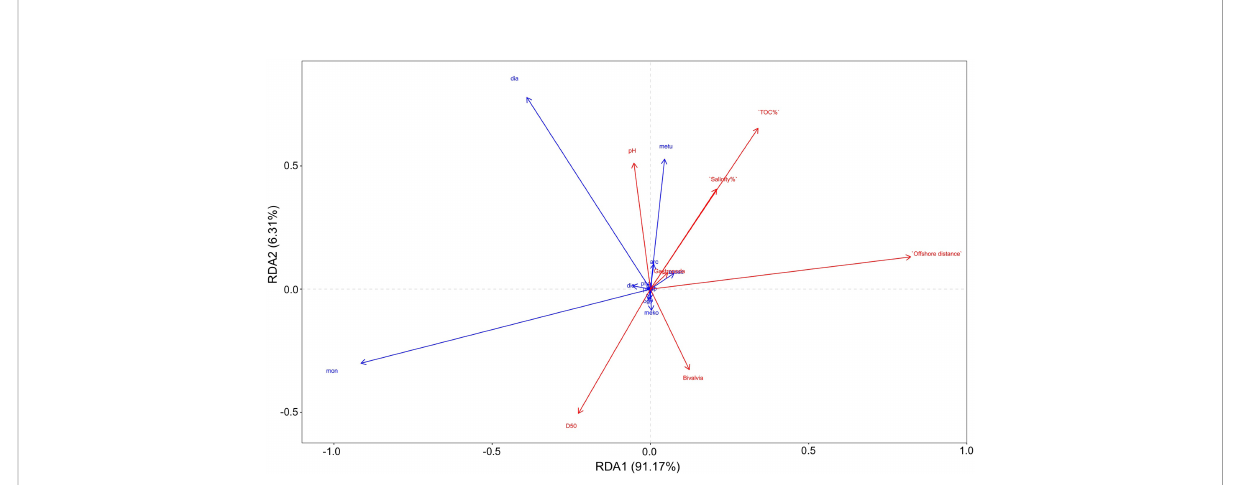
FIGURE 6 Redundancy analysis results of the relationship between arthropod density and environmental factors.